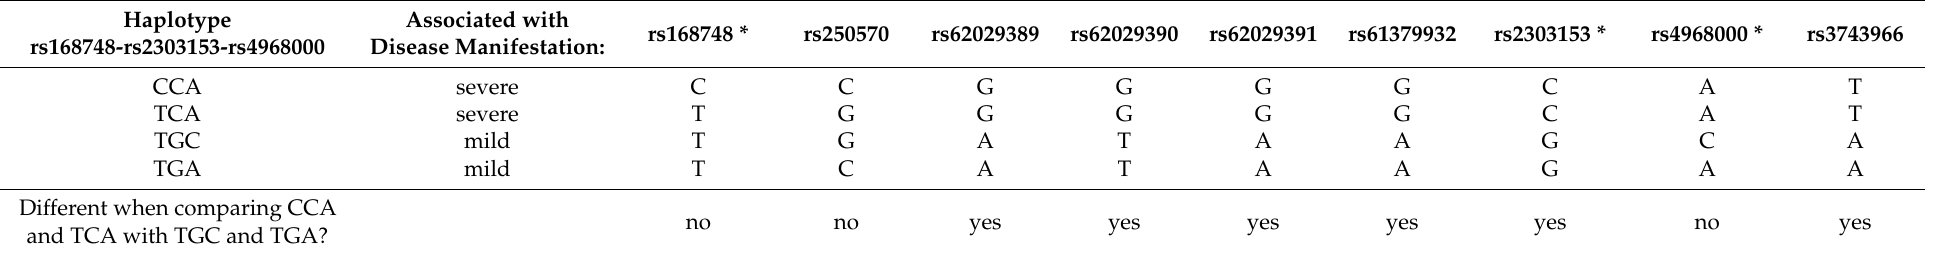
Table 1. Variants observed on contrasting haplotypes identified after Sanger resequencing of the 3.000 bp genomic fragment defined by rs168748 to rs4968000.